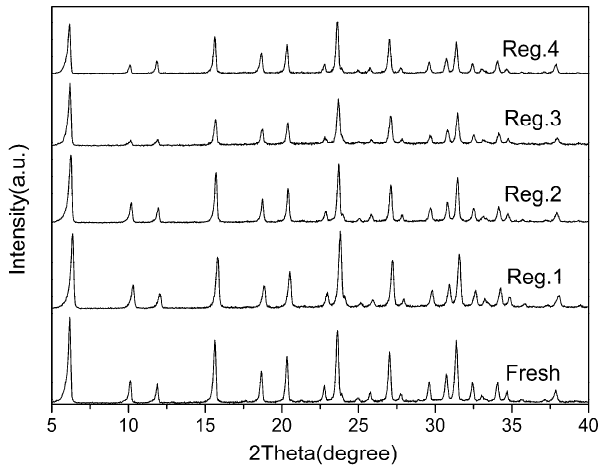
Figure 9. XRD patterns of fresh and regenerated Zn(Ac) 2 -Y.